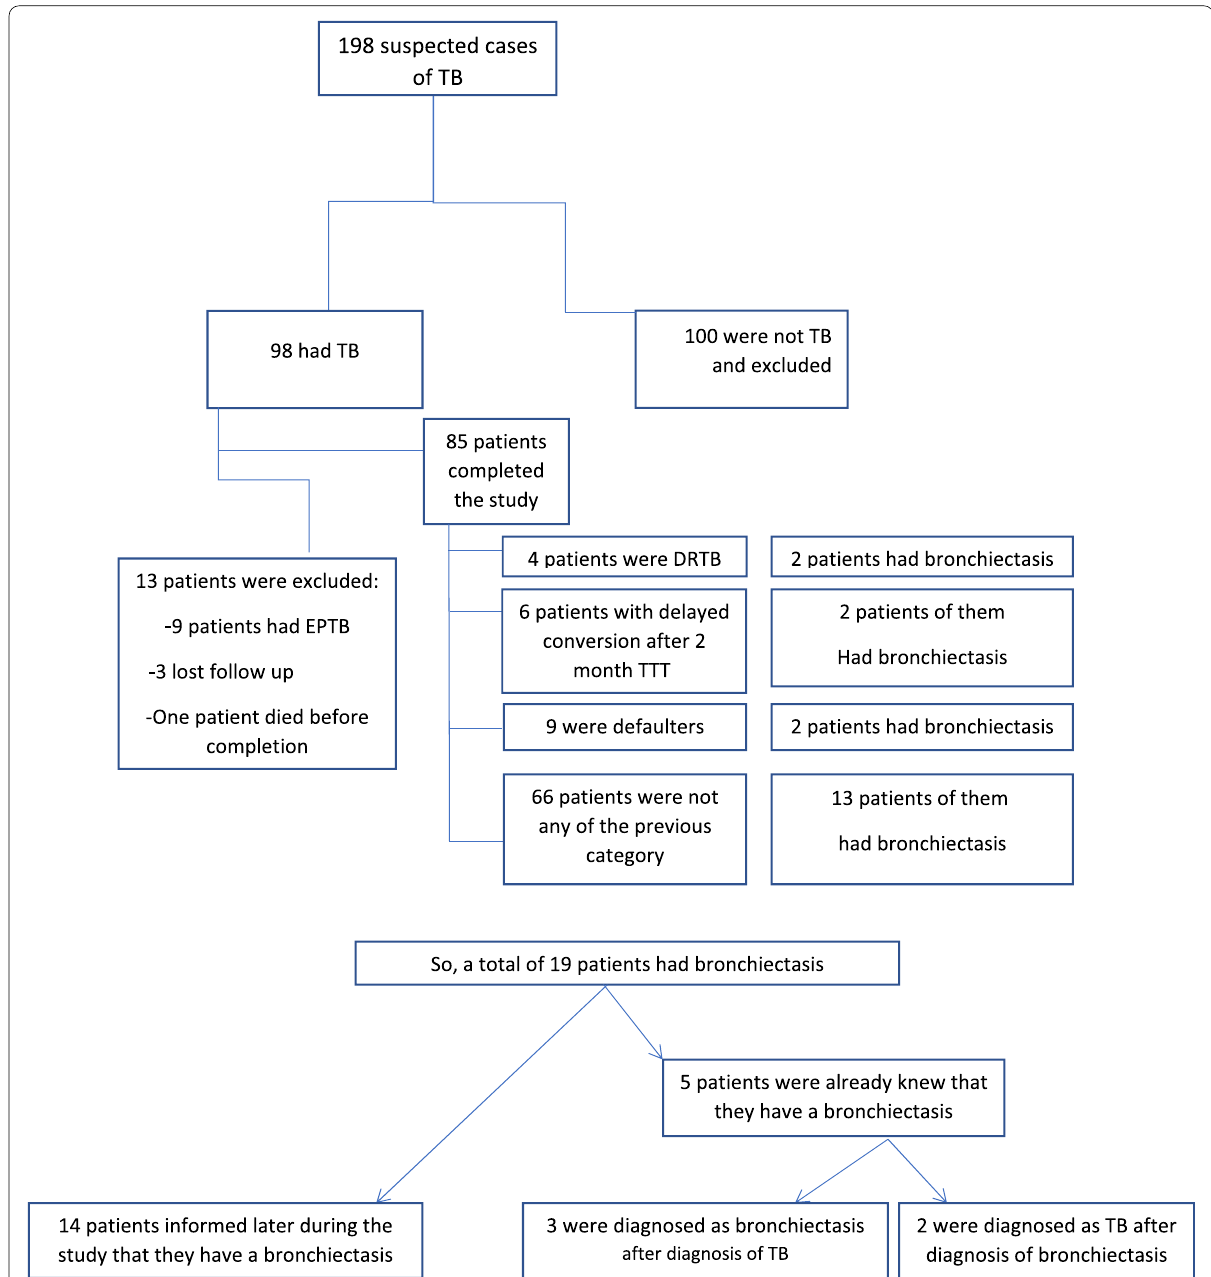
Fig. 1 Flow chart of the tuberculosis patients included in the current study. TB tuberculosis, DRTB drug‑resistant tuberculosis, and EPTB extrapulmonary